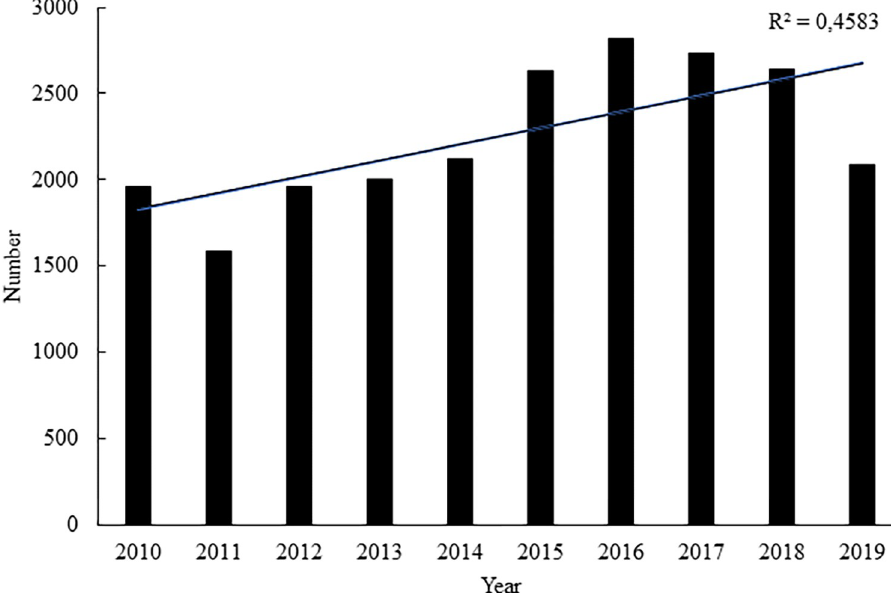
Fig 1. Number of raptors admitted to rescue centres in the Czech Republic in the individual years of the monitored period.